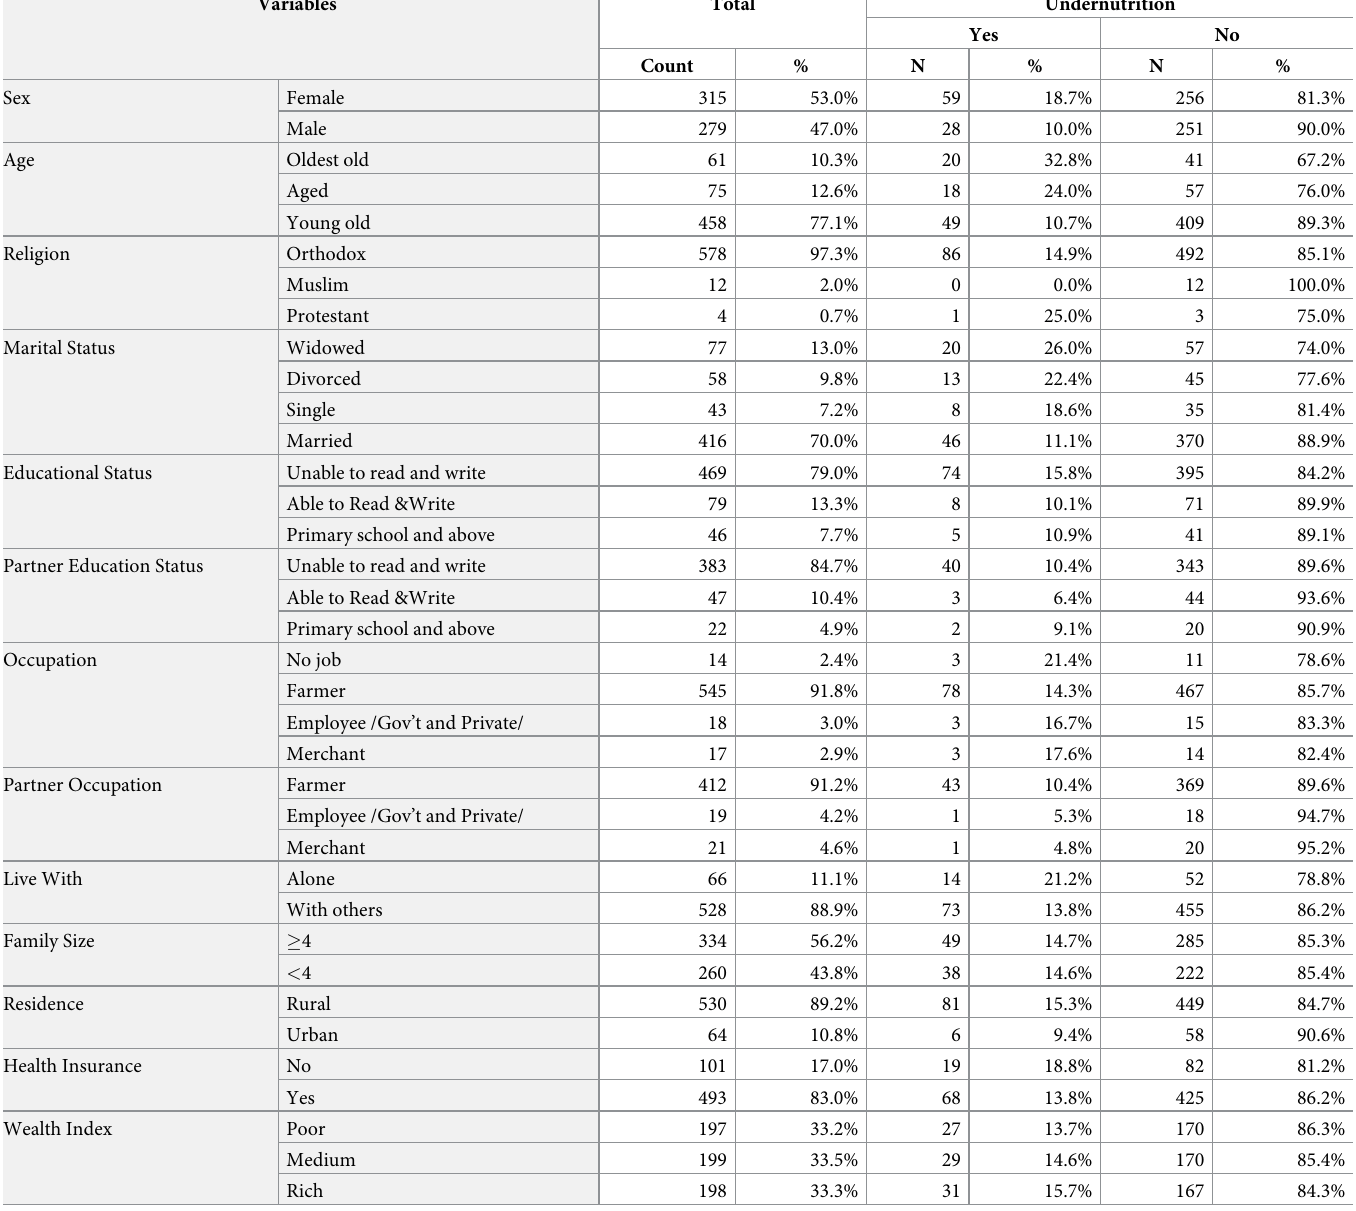
Table 1. Distribution of socio-demographic characteristics of undernutrition among the older adults in Womberma district, North West Ethiopia, 2020 (n = 594).